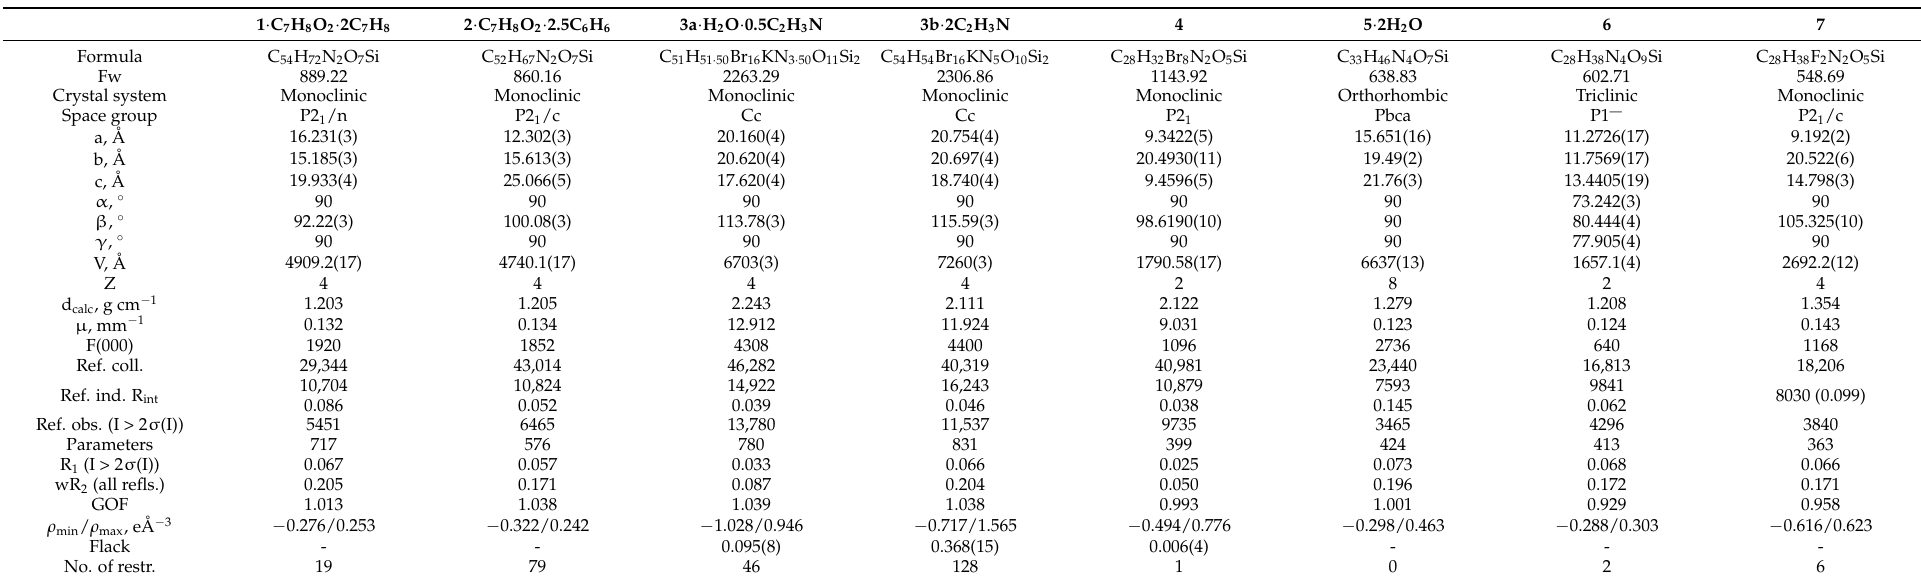
Table 3. Crystal parameters and refinement details for salts 1 – 7